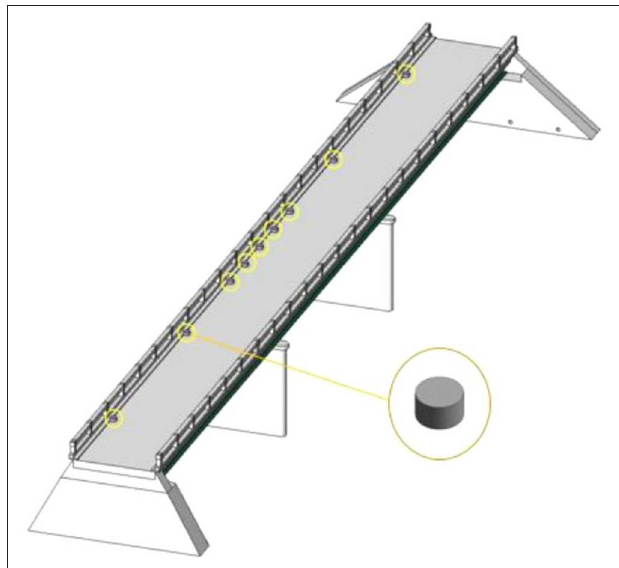
FIGURE 6 | Three-dimensional virtual model for bridge and sensor.